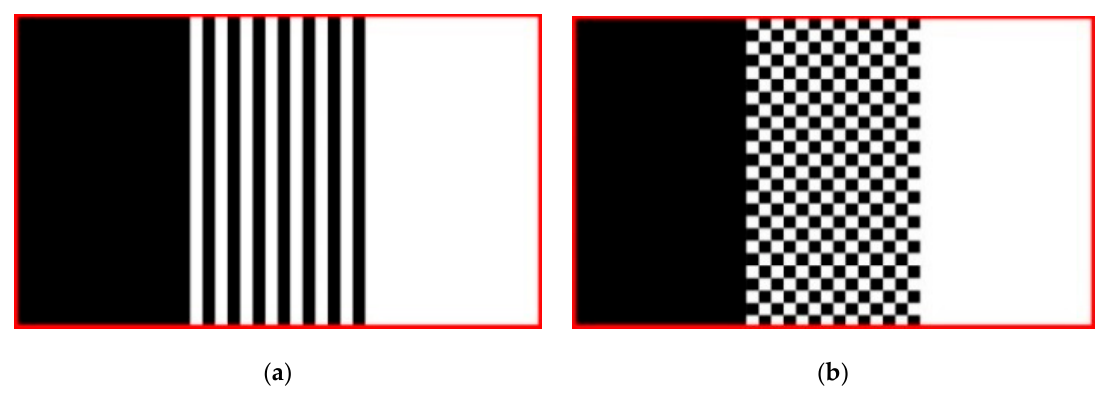
Figure 2. The improved ternary Gray-code method. ( a ) Conventional 1D modulation; ( b ) Improved 2D modulation.